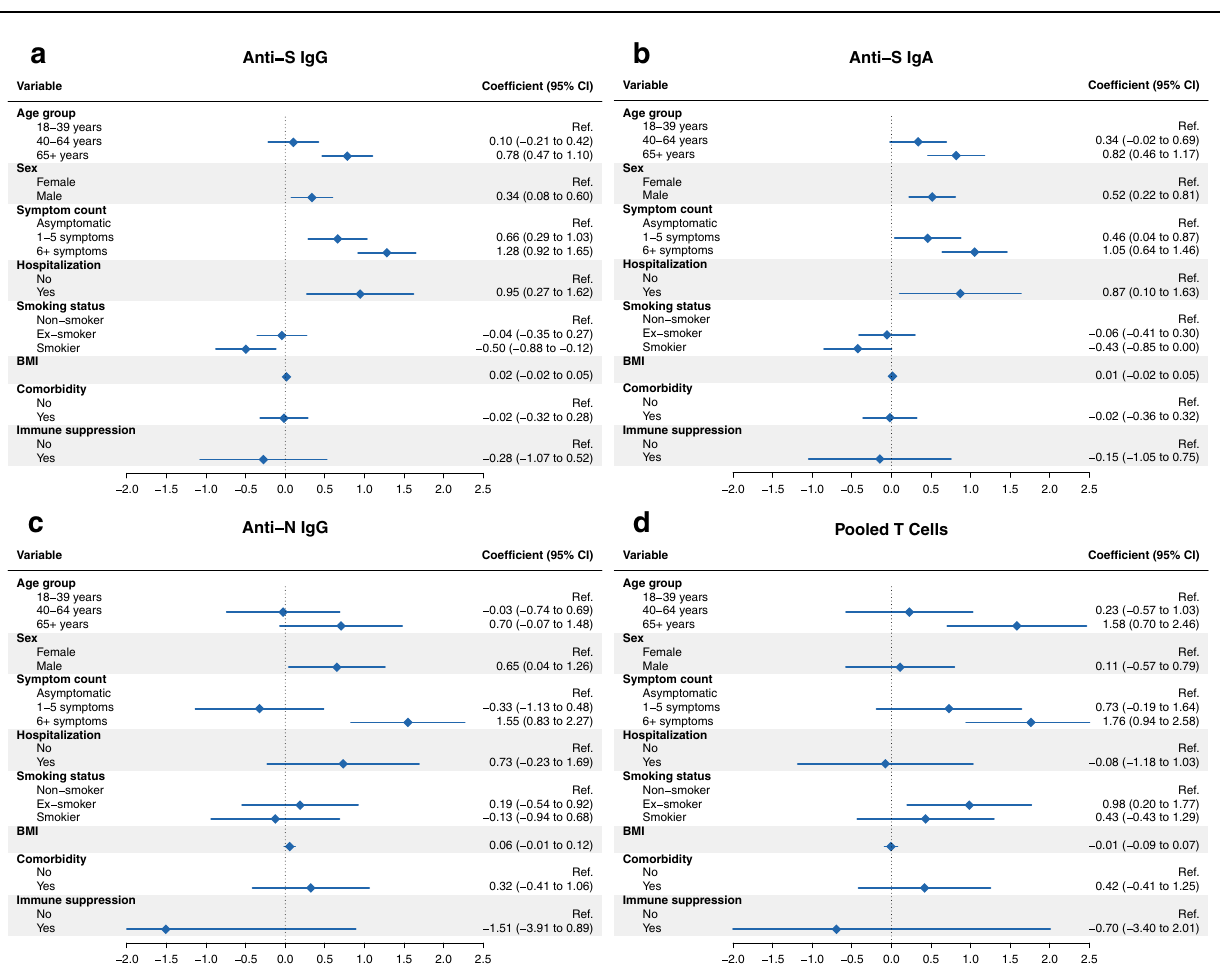
Fig. 7 | Association analyses of antibody and T cell responses. a Forest plot demonstrating results from adjusted mixed linear regression analyses evaluating the associations of anti-S IgG mean fl uorescence intensity (MFI) ratios with demographic and clinical factors (age, sex, COVID-19 symptom count, smoking status, body mass index, presence of at least one comorbidity and immunosup- pression)intheoverallstudypopulation(total n =431).Themodelwasadjustedfor time since diagnosis, age group, sex, and disease severity expressed as symptom count, with a random intercept for each individual. Points and error bars in panels a – d represent estimated coef fi cients with associated 95% con fi dence intervals (CIs). BMI: body mass index. b Forest plot showing results from adjusted mixed